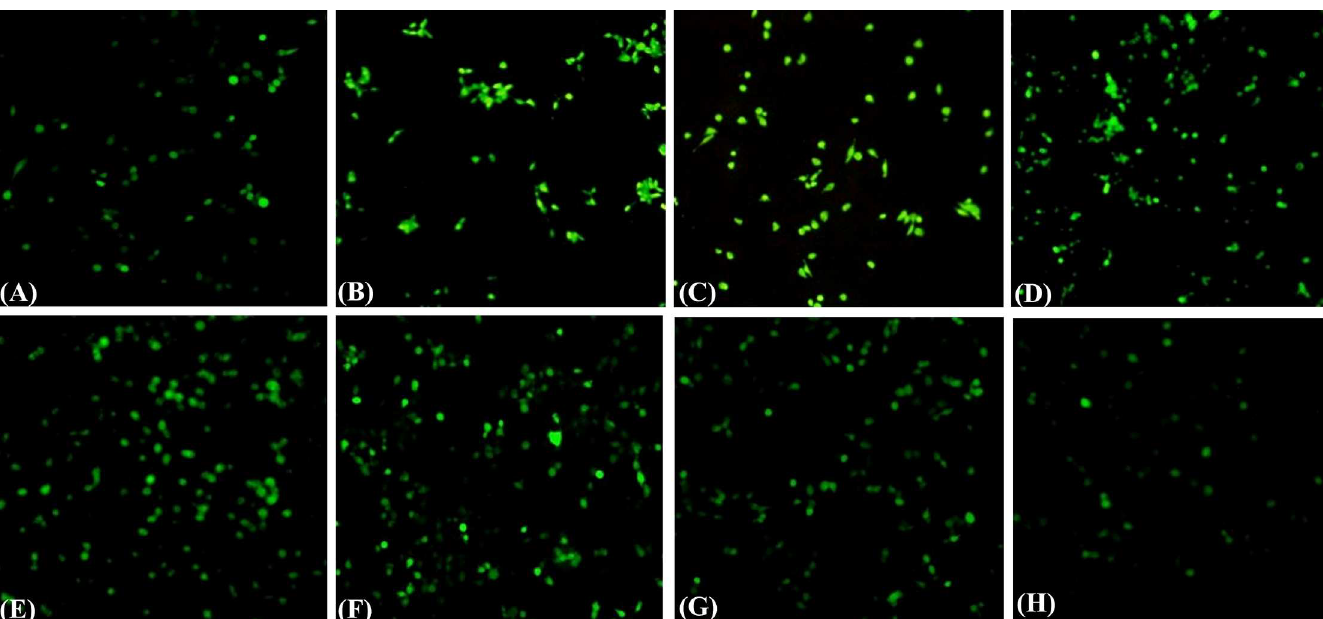
Fig 7. Effects of CBLin depletion of intracellular ROS production generated by CCl 4 in WRL-68 cells. Production of ROS was measured by cleavage of acetate group of non-fluorescent H 2 DCFDA (2’,7’-dichlorodihydrofluorescein diacetate) which convert into DCF(2 0 ,7 0 -dichlorofluorescein) highly fluorescent. Cells were exposed to CCl 4 before treatment with CBL 50, 80, 100, 150 and 200 μ g/ml for 24 h. The ROS production displays the intensity of fluorescence through the images of WRL-68 cells treated with different concentration of CBL (D-H) , CCl 4 (C) , H 2 O 2 (B) and control (A) .